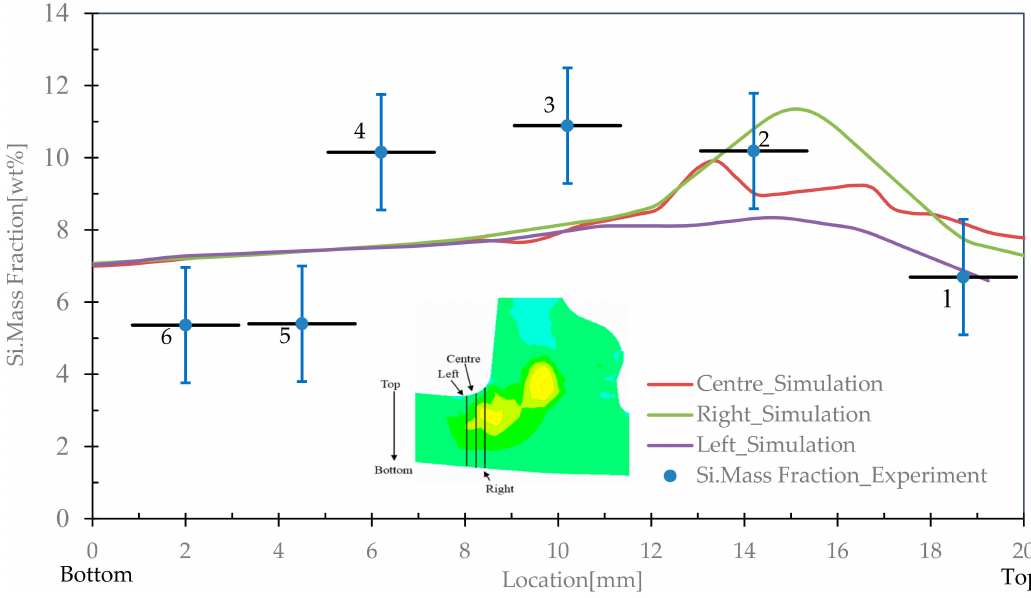
Figure 7. Comparison between the experimental data (dots) and simulated (lines) silicon mass fraction in the